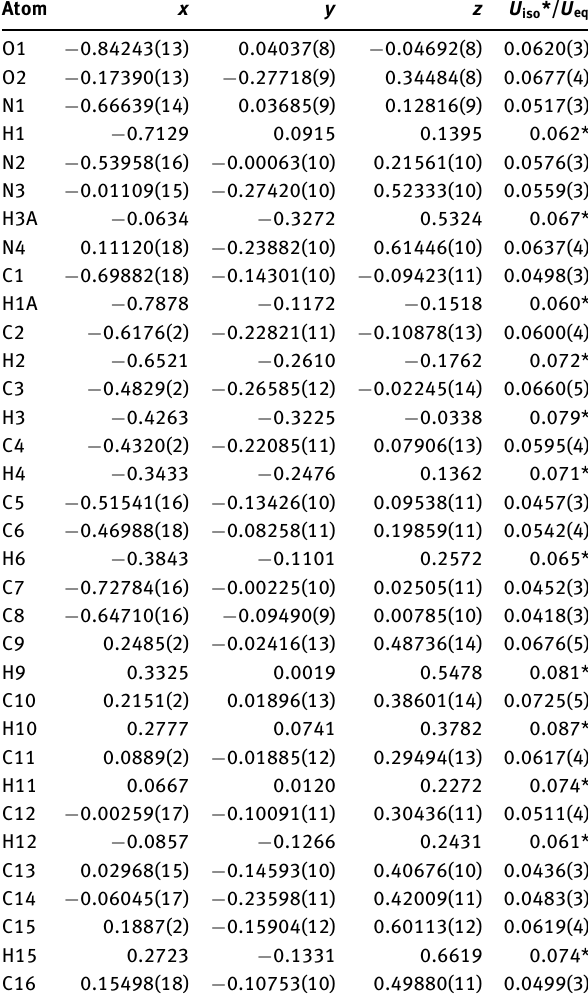
Table 2: Fractional atomic coordinates and isotropic or equivalent isotropic displacement parameters (Å 2